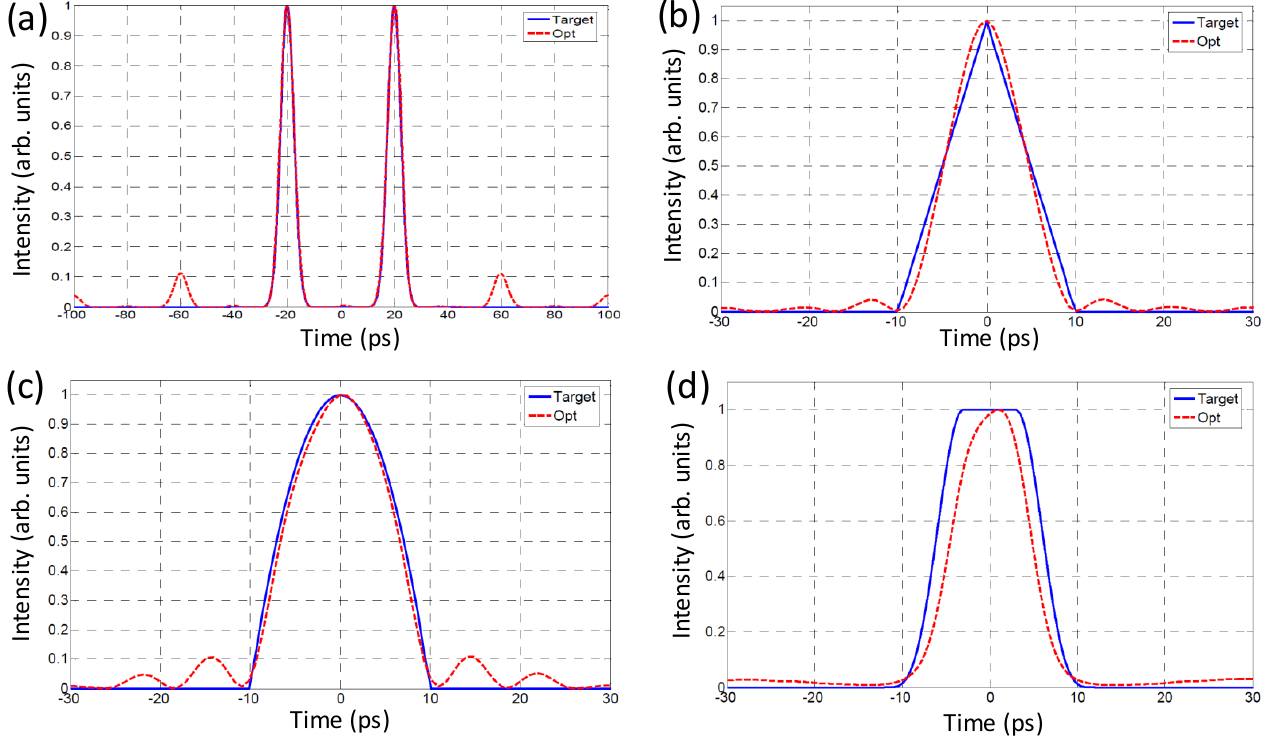
Figure 10. A representative example of the optimized and target waveform obtained shown in Figure 4. ( a ) using Brute Force MC, ( b ) using Simulated Annealing, ( c , d ) using the Genetic Algorithm.